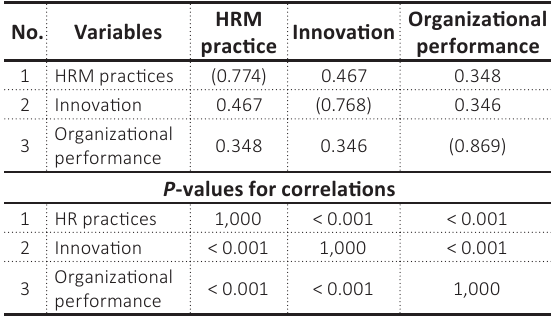
Table 3. Correlations among latent variables